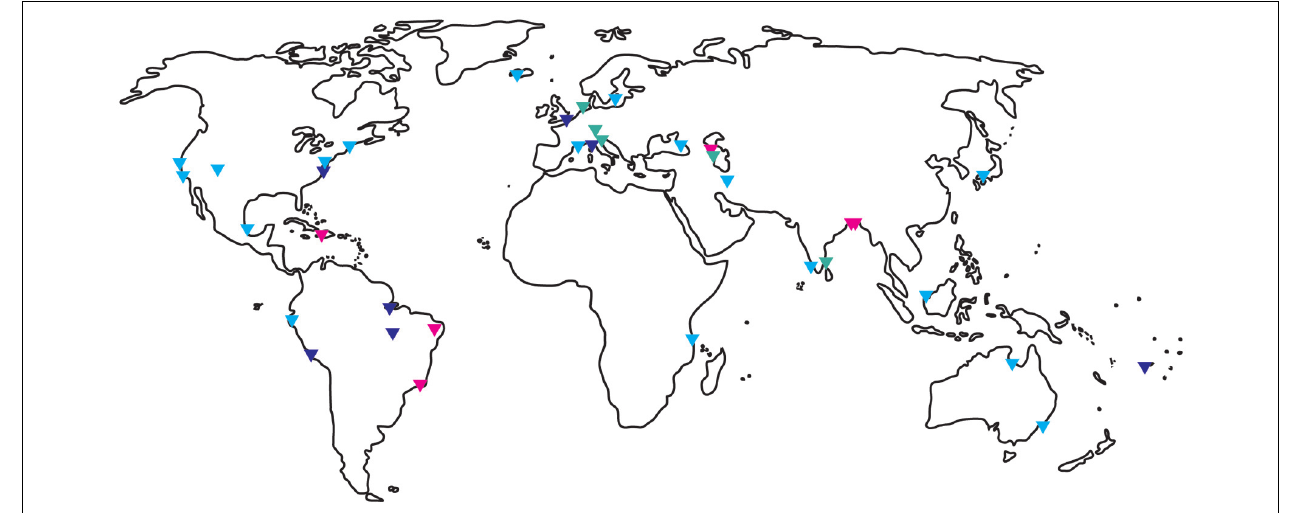
Lipp etal., 2003; Leal etal., 2008; Martinelli Filho etal., 2010; Sá etal., 2012); Africa: (Taviani etal., 2008); Europe: (Andersson and Ekdahl, 2006; Covazzi Harriague etal., 2008; Kirschner etal., 2008; Vezzulli etal., 2009, Vezzulli etal., 2011; Böer etal., 2013; Cantet etal., 2013; Tall etal., 2013);